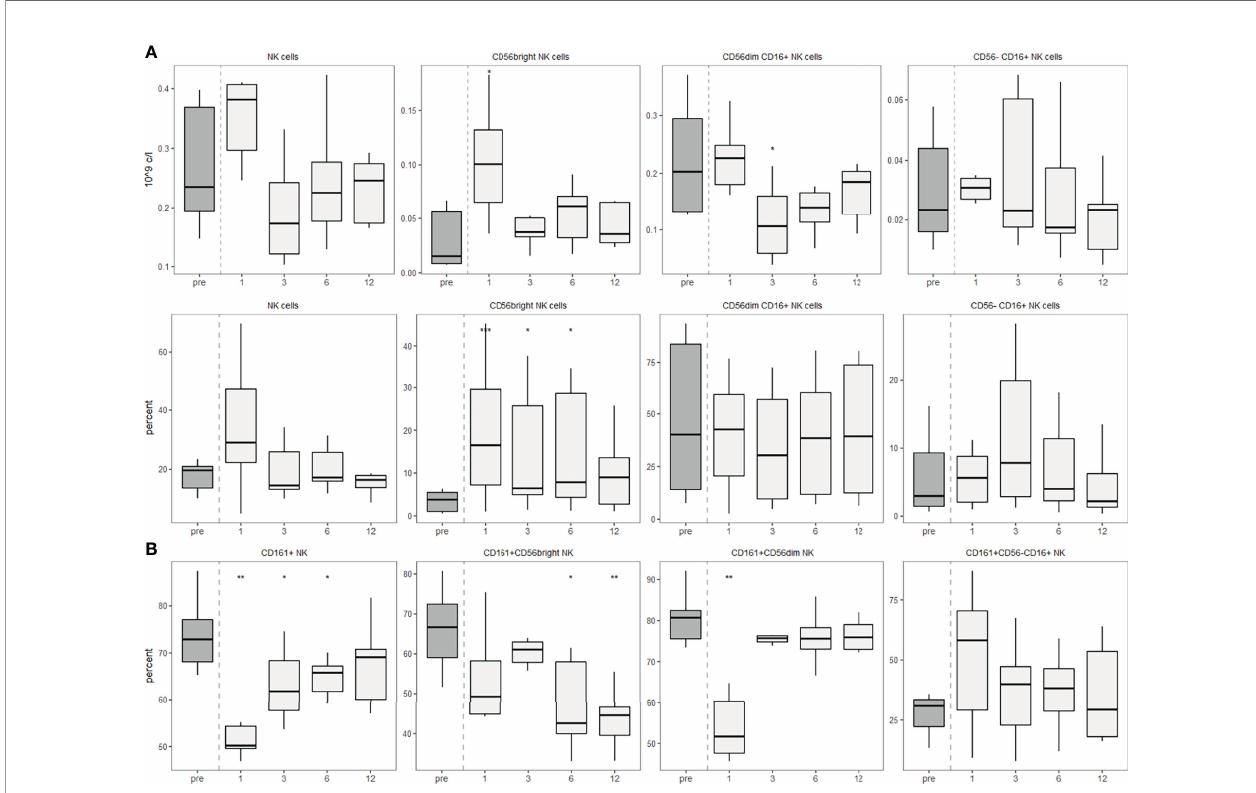
FIGURE 7 | CD56 dim NK cells express permanently less surface CD161 after aHSCT in MS. PBMCs were stained with fl uorophore-conjugated surface antibodies and analyzed by fl ow cytometry. (A) Absolute (top) and relative (bottom) recovery of NK cells (left, percentage of lymphocytes) and CD56 bright , CD56 dim CD16+ and CD56-CD16+ NK cell subsets (percentage of NK cells). (B) Expression of CD161 by all NK cells (left) and their subpopulations. Number of samples were pre = 7, M1 = 7, M3 = 7, M6 = 7, M12 = 7. As a global test, Kruskal-Wallis was used, and in case of signi fi cance followed by pairwise comparisons (pre vs 1, 3, 6 and 12 months) using Wilcoxon signed-rank